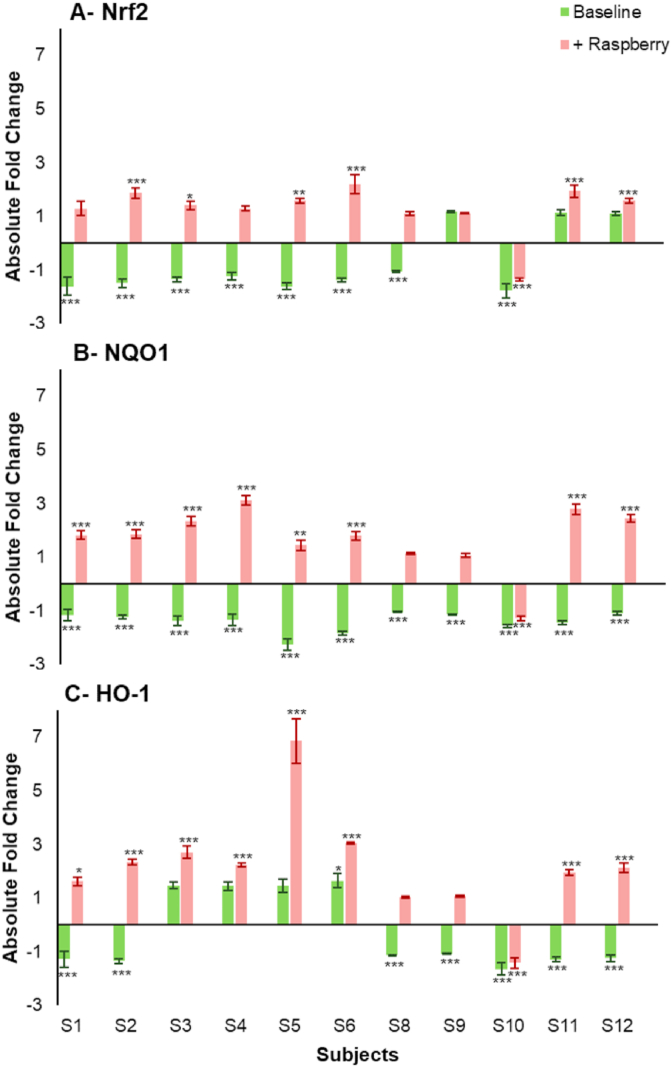
Changes in (A) Nrf2, (B) NQO1, (C) HO-1 gene expression after incubation for 24 h with Baseline and +Raspberry ileal fluid fermented for 24 h (20% v/v). Gene expression in CCD841 cells is presented as mean of 3 independent experiments ±SDM and expressed as absolute fold change. Significance is compared to normalised untreated control using One-way ANOVA and Dunnett's Multiple Comparisons test. *p < 0.05, **p < 0.01, ***p < 0.001.